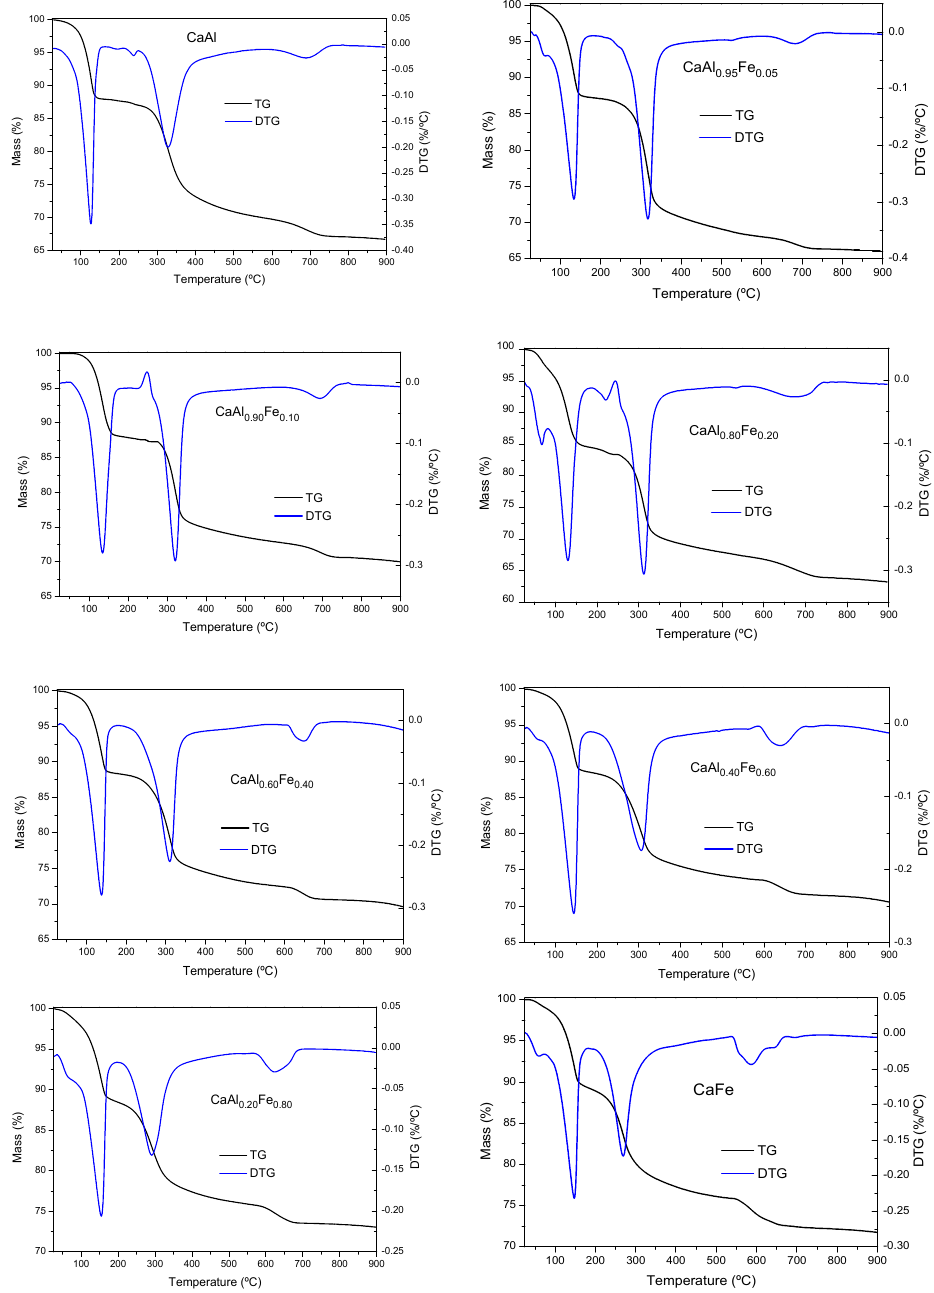
Figure 4. TG and DTG curves of the solids synthesized.